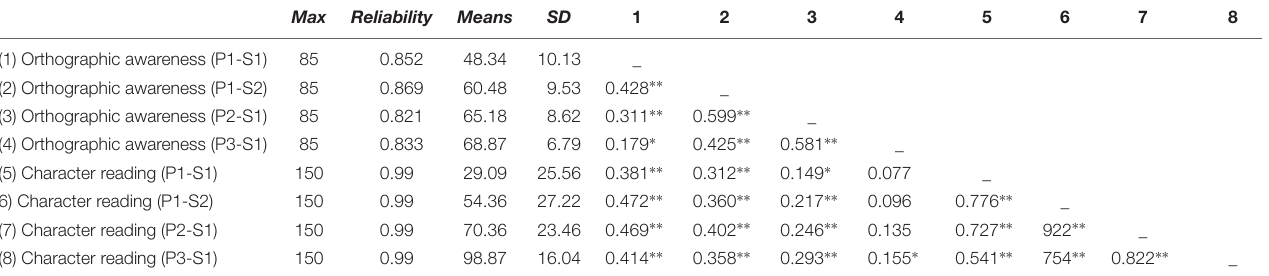
TABLE 2 | Reliabilities, means, SD and correlations of orthographic awareness and character reading in the primary school sample. Max Reliability Means SD